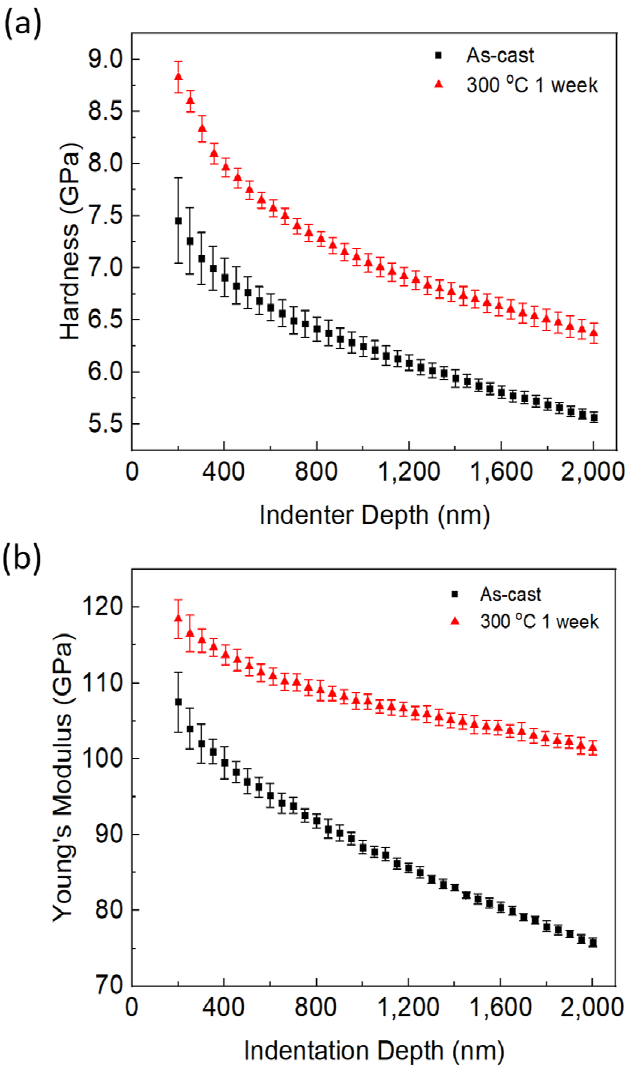
Figure 2. ( a ) Nanoindentation hardness vs. indentation depth for the as-cast and annealed (300 °C, 1 week) Zr 52.5 Cu 17.9 Ni 14.6 Al 10 Ti 5 BMG samples. ( b ) Nanoindentation Young’s modulus vs. indentation depth for the as-cast and annealed (300 °C, 1 week) Zr 52.5 Cu 17.9 Ni 14.6 Al 10 Ti 5 BMG samples for